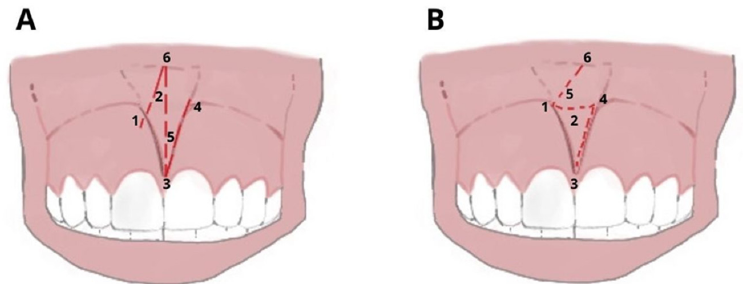
Figure 4. Z-Plasty: ( A ) Vertical incision in the center of the frenulum, with releases parallel to 60° to form a Z and ( B ) transposition of the mucous flaps of triangular shape and suture: the orientation of the fibers that were vertical rotates and becomes horizontal. ( 1 – 6 ) The numbers refer to the chronology of execution of the incision.